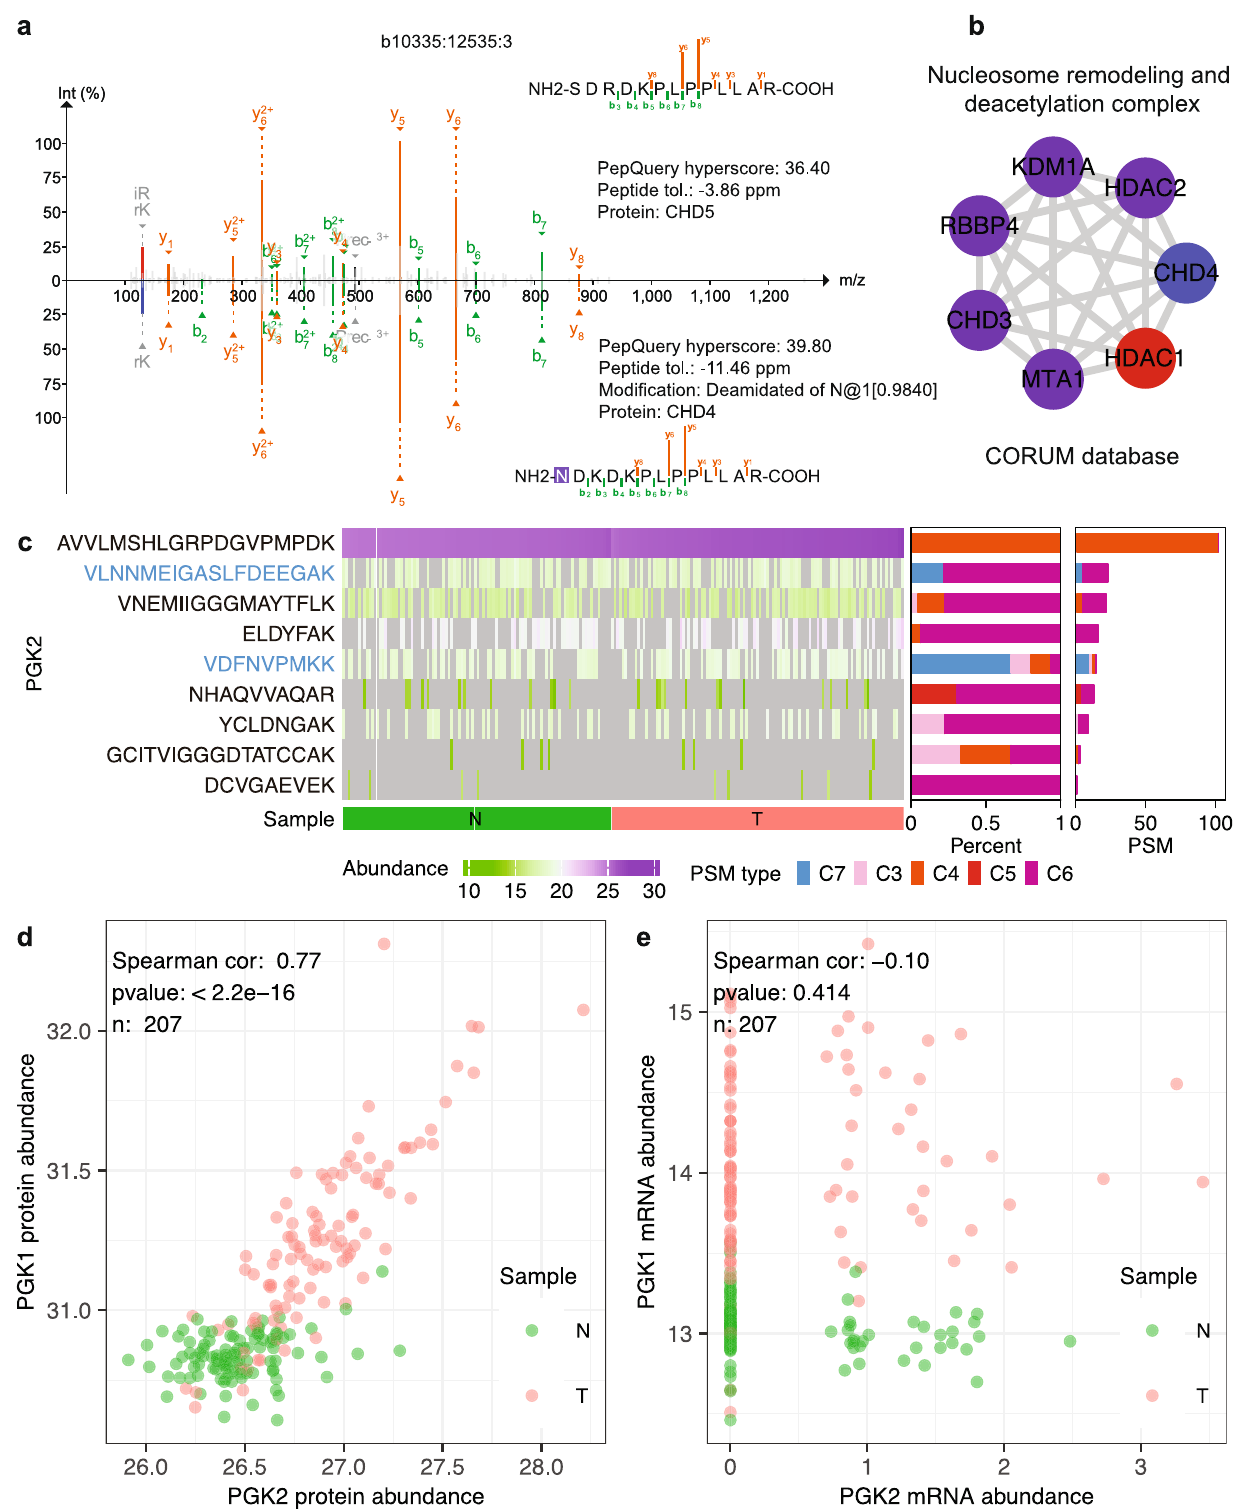
Fig. 4 | Validation of known peptide identi fi cation. a An originally reported spectrum identifying CHD5 in an AP-MS experiment using HDAC1 as the bait was found by PepQuery2 to have a better match to a peptide from CHD4 with deami- dation. b A protein complex containing both HDAC1 and CHD4 in the CORUM database. c PepQuery2 classi fi ed previously identi fi ed and quanti fi ed PGK2 pep- tidesintodifferentcategories.Onlythepeptideshighlightedinbluefonthadoneor